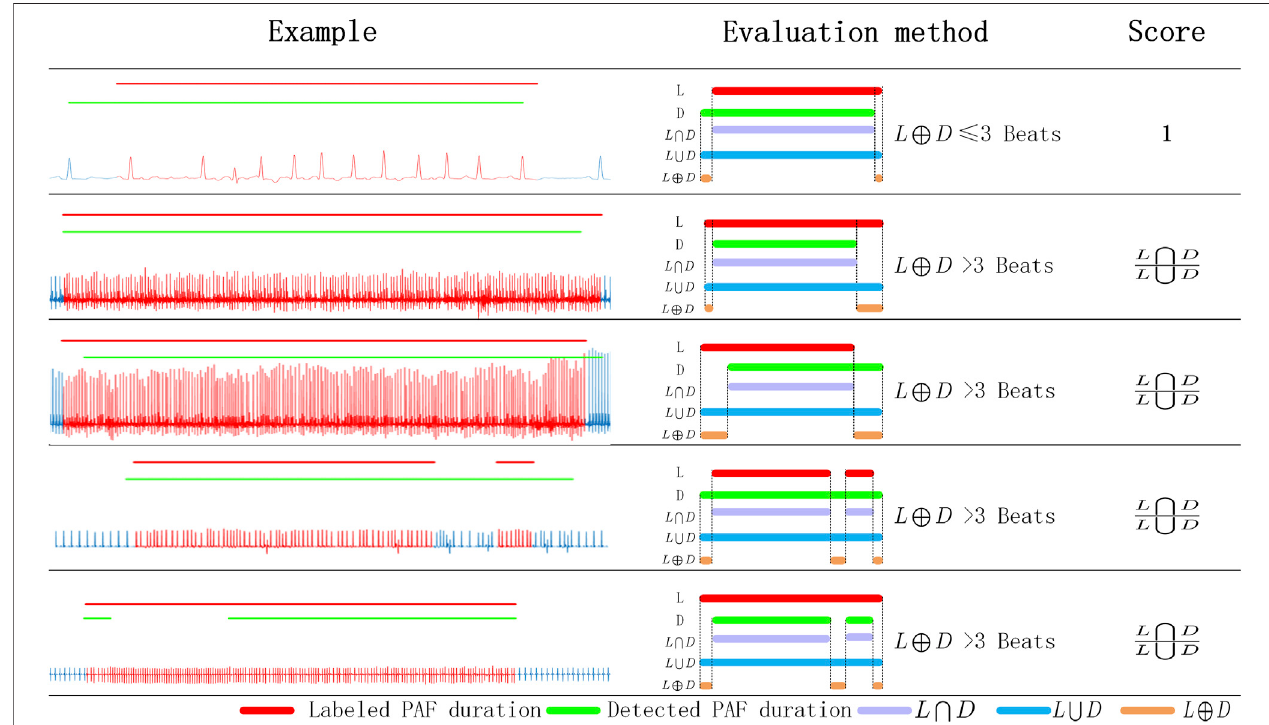
FIGURE3| TheevaluationschemeofPAFdetectionresult.L:labeledPAFduration;D:detectedPAFduration; L ⋂ D :theintersectionofLandD; L ⋃ D :theunionofL and D; L ⊕ D : the exclusive-OR of L and D.